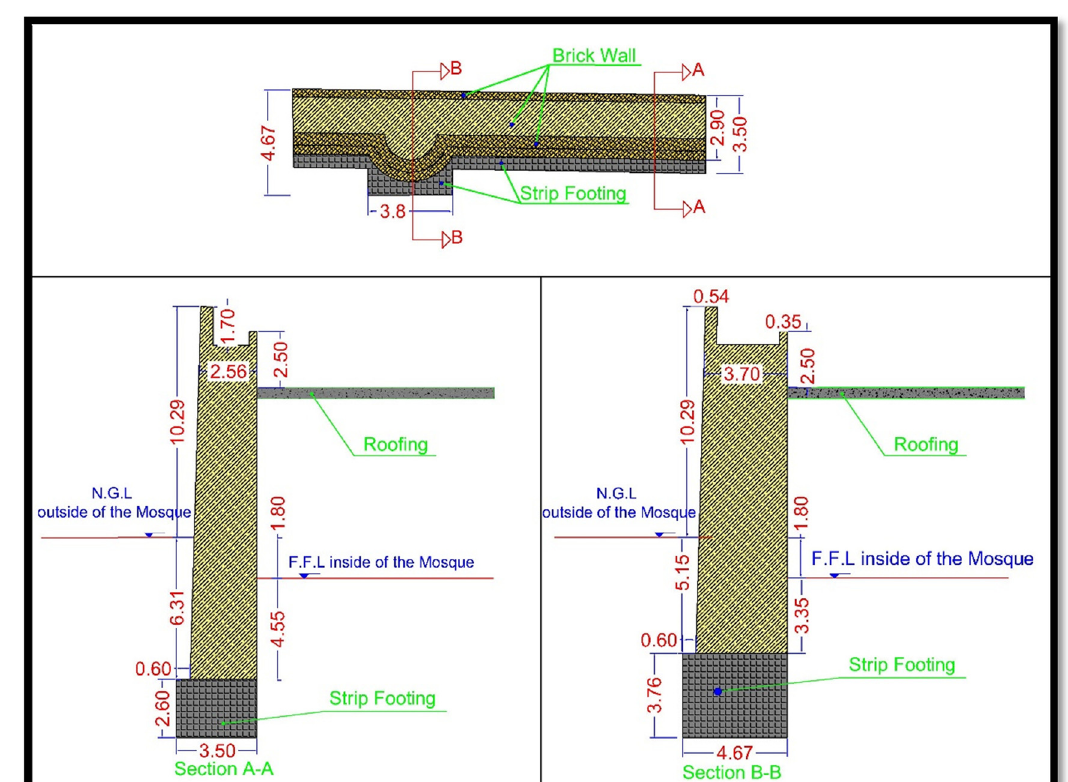
Figure 2: The wall and foundation details of Al - Kufa Mosque.